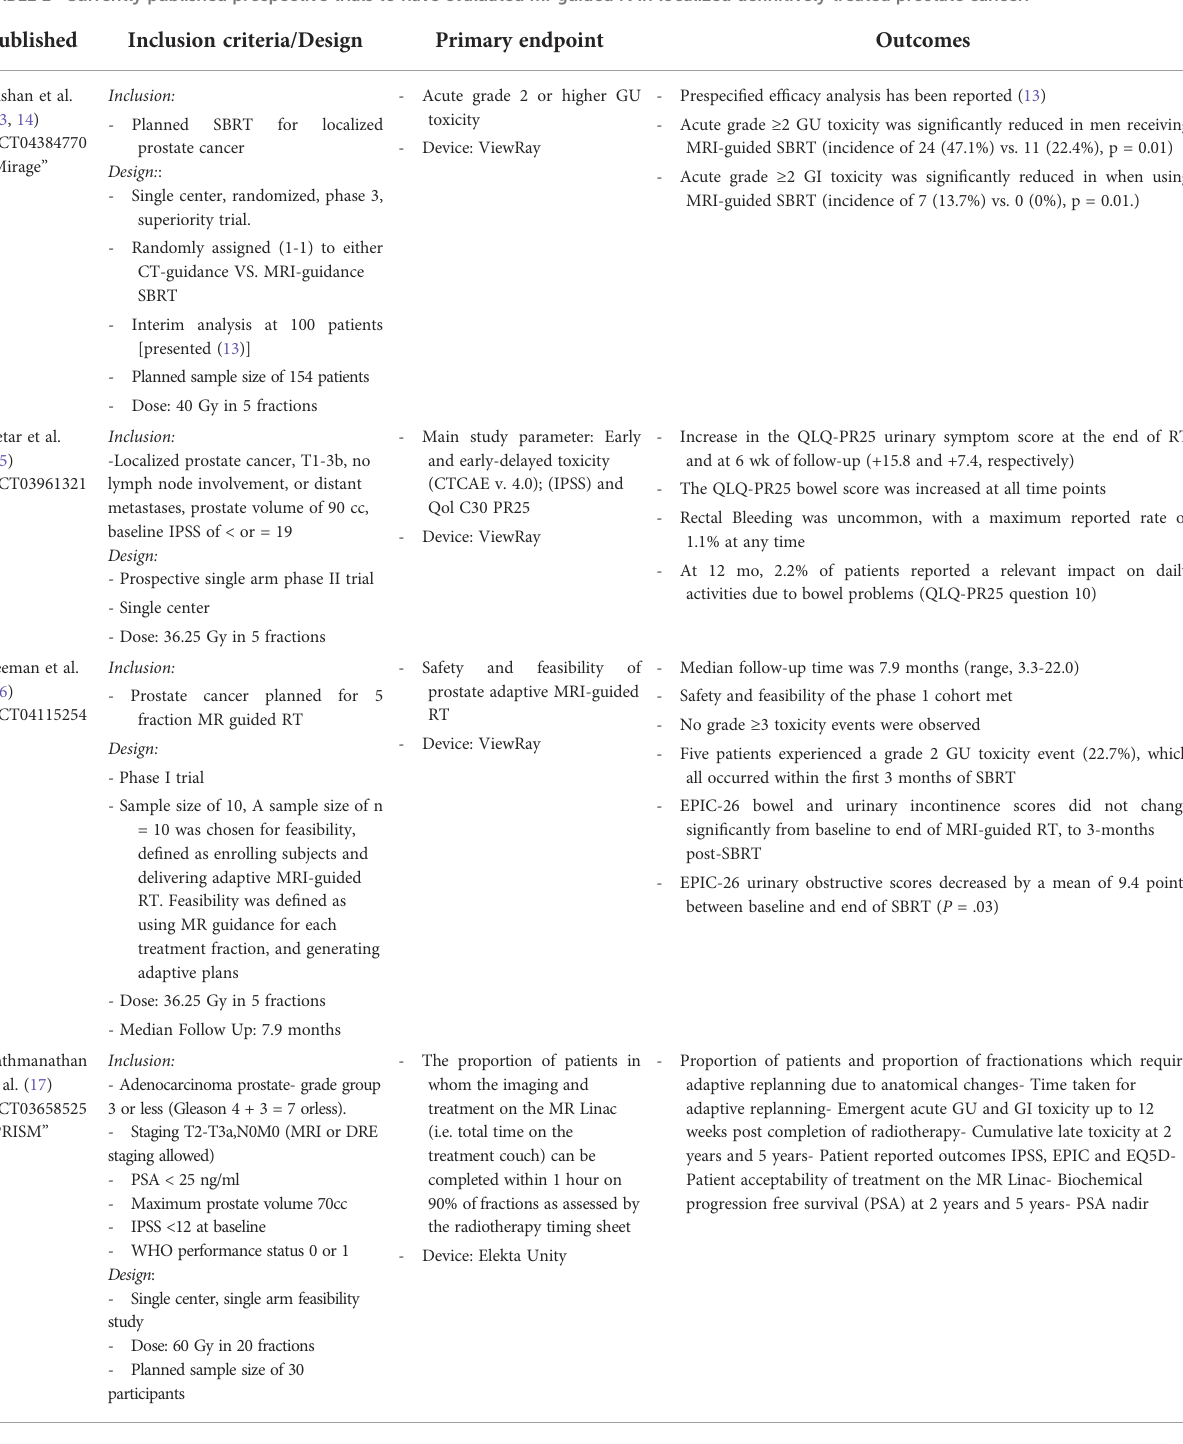
TABLE 1 Currently published prospective trials to have evaluated mr guided rt in localized de fi nitively treated prostate cancer. Published Inclusion criteria/Design Primary endpoint Outcomes Kishan et al. (13,